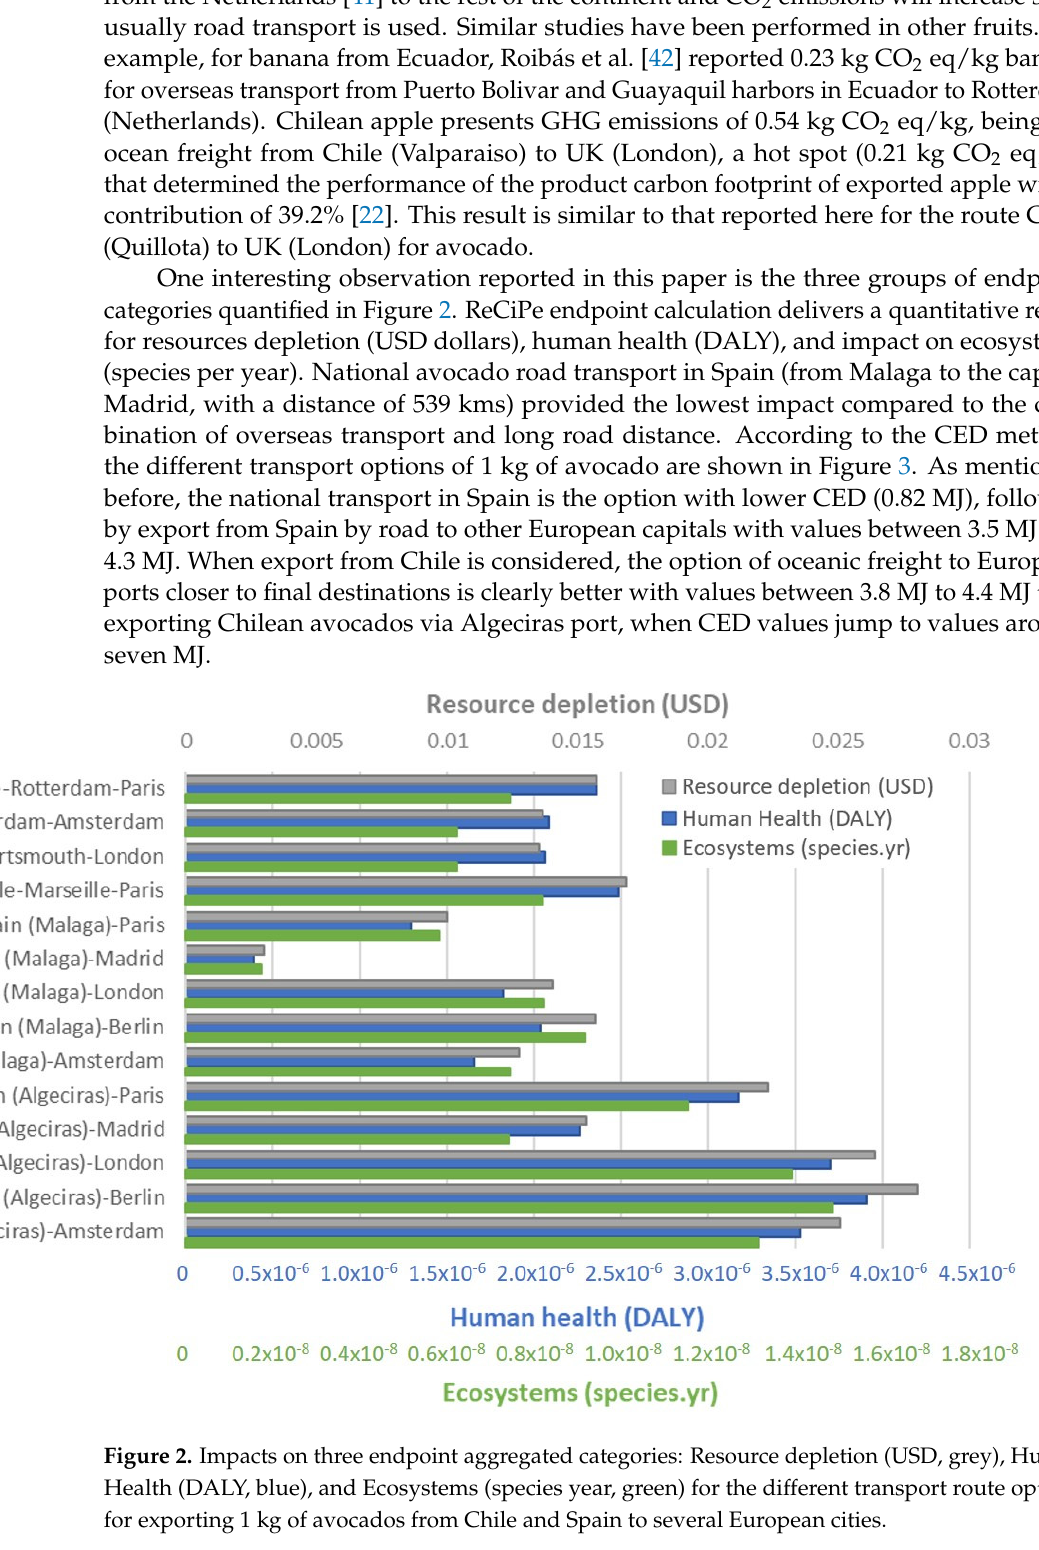
Figure 3. Cumulative primary energy demand (MJ) for the different routes of transport of 1 kg of avocados. Chile and Spain are considered as the travel origin; for Chile two options are considered: (i) export via Algeciras port and then using the same route as Spain exports (lower five bars) and (ii) export via Rotterdam, Portsmouth, or Marseille (as indicated in the four upper bars) and the road to the respective city.